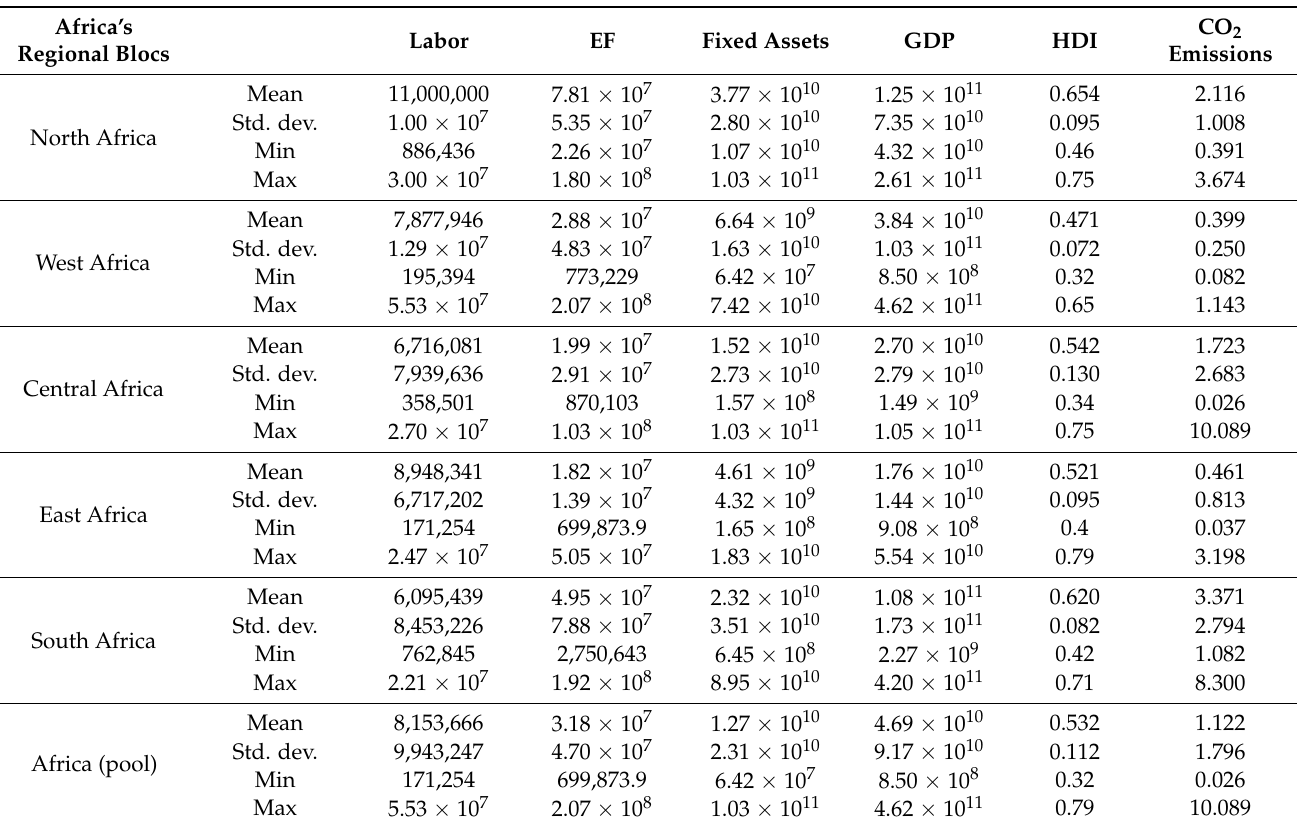
Table 2. Summary (descriptive) statistics the output, carry-over, and input indicators in